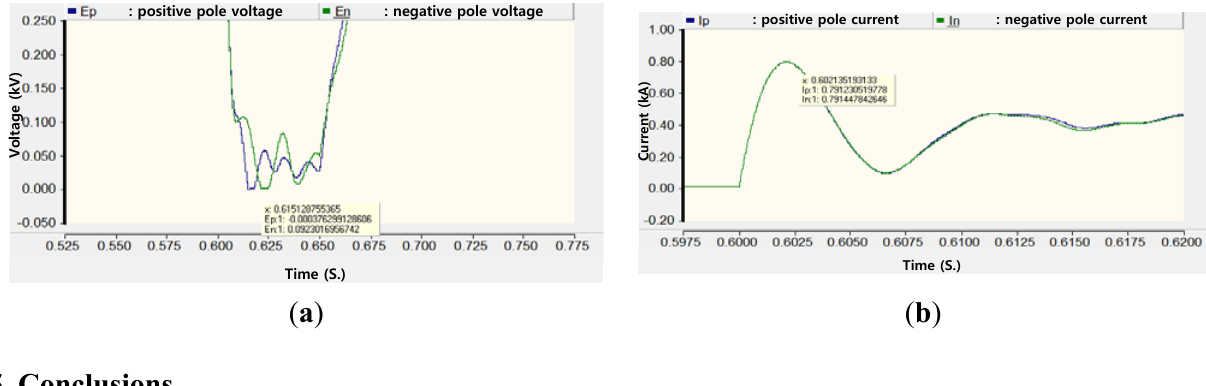
Figure 9. Enlarged resulting waveforms of O/H line: ( a ) voltage and ( b )